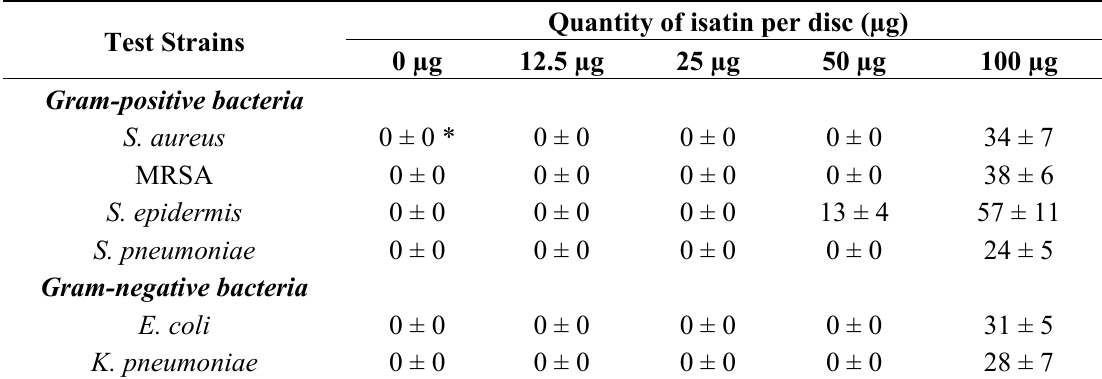
Table 3. The antimicrobial effect of isatin (Sigma) on tested microorganisms. Only the strains sensitive to the isatin are shown.